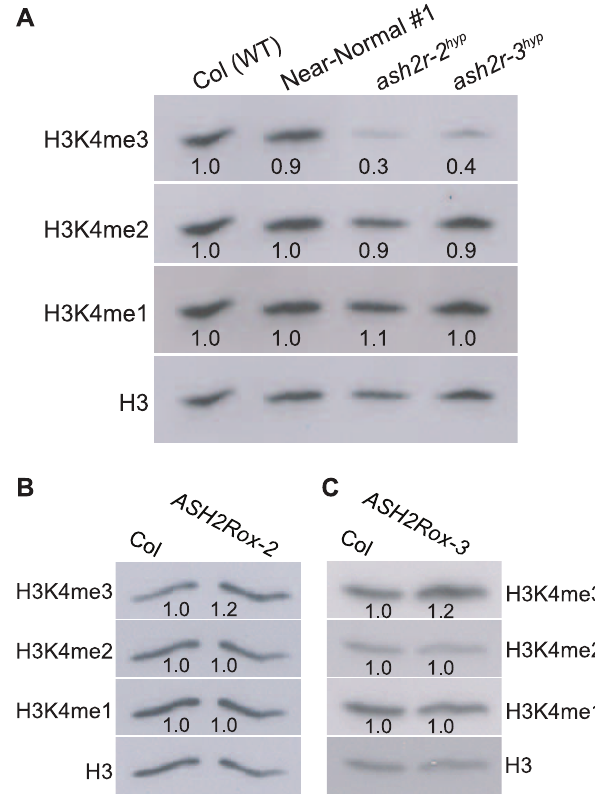
Figure 9. Analyses of Genome-Wide H3K4 Methylation upon Loss of ASH2R Function or ASH2R Overexpression. (A) Loss of ASH2R function causes a strong reduction in global H3K4me3, but not H3K4me2 or H3K4me1. Total histones were extracted from 10-d-old seedlings of Col (WT) and the strong hypomorphic ash2r-2 hyp and -3 hyp , and subsequently were analyzed by western blotting. Total H3 in each sample serves as a loading control. The intensity of each protein band was quantified with the Quantity One software, and subsequently, was normalized to total H3. Values are fold changes of ash2r-2 hyp or ash2r- 3 hyp over WT. (B–C) Analysis of levels of global H3K4me1, H3K4me2 and H3K4me3 in the ASH2R overexpression lines ASH2Rox-2 and -3 . Total histones were extracted from 10-d-old seedlings of Col, ASH2Rox-2 and ASH2Rox-3 , and subsequently, were analyzed by western blotting.